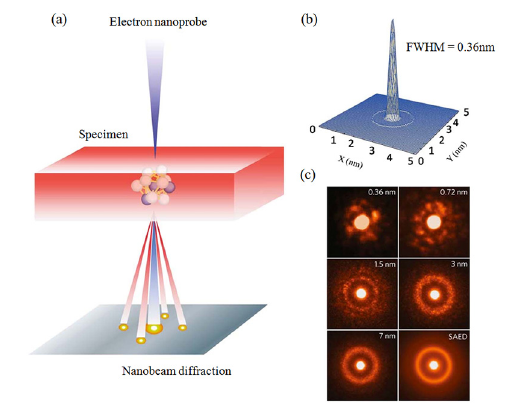
Figure 10. (a) The experimental principle; (b) The three-dimensional profile of a calculated electron nanoprobe with a FWHM beam size